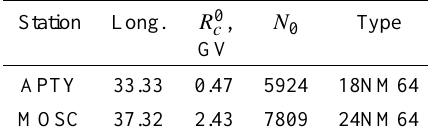
Table 1. Characteristics of NM stations